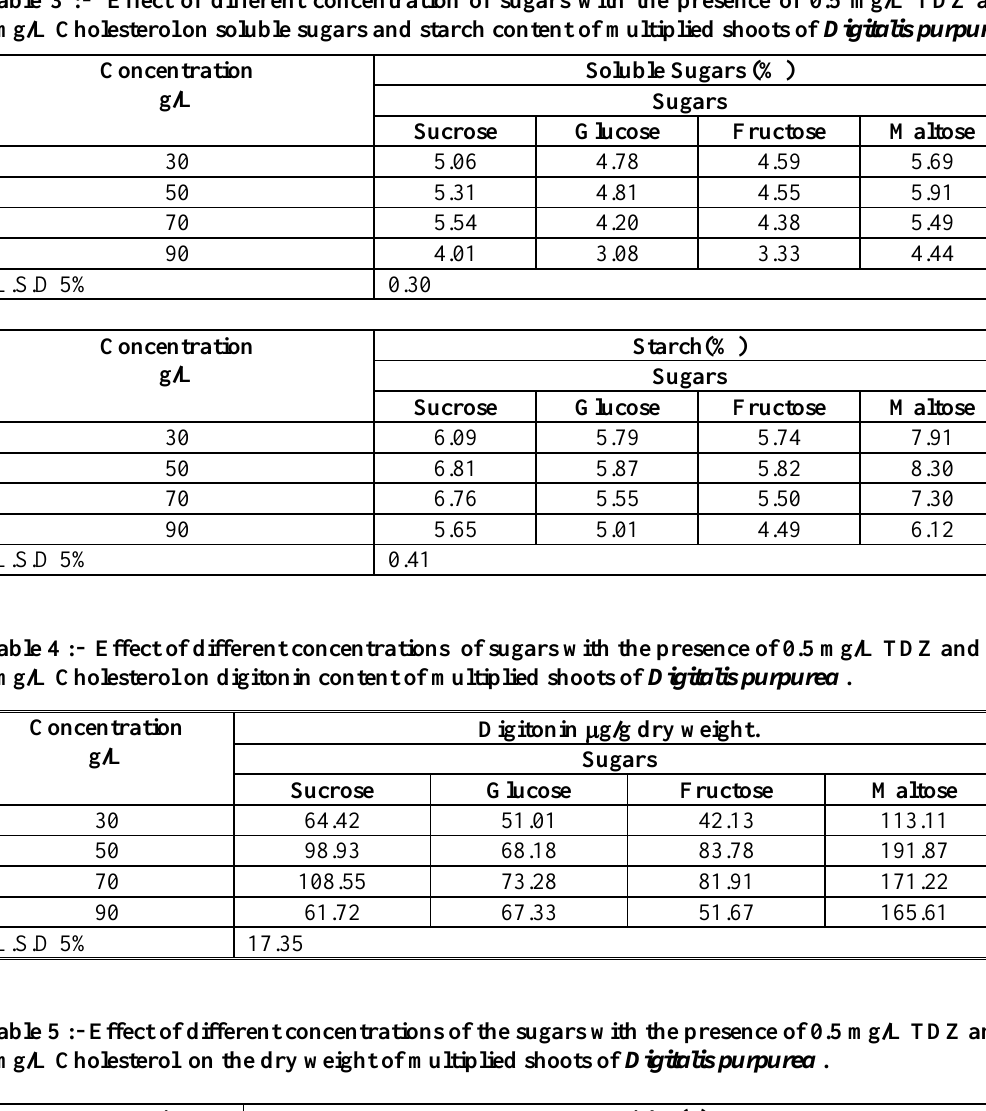
Table 3 :- Effect of different concentration of sugars with the presence of 0.5 mg/L TDZ and